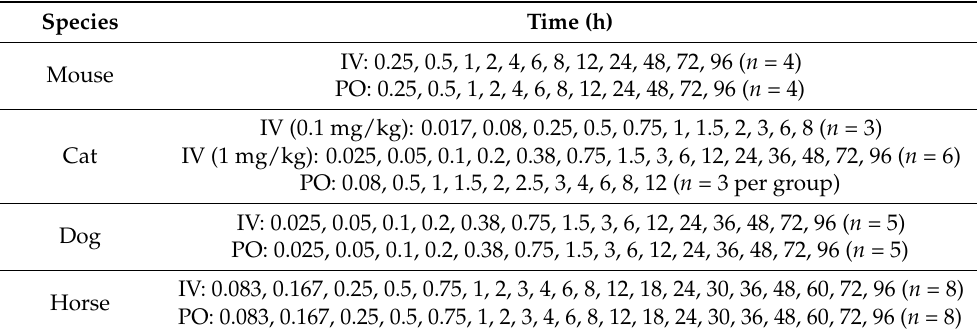
Table 5. Blood samples times post